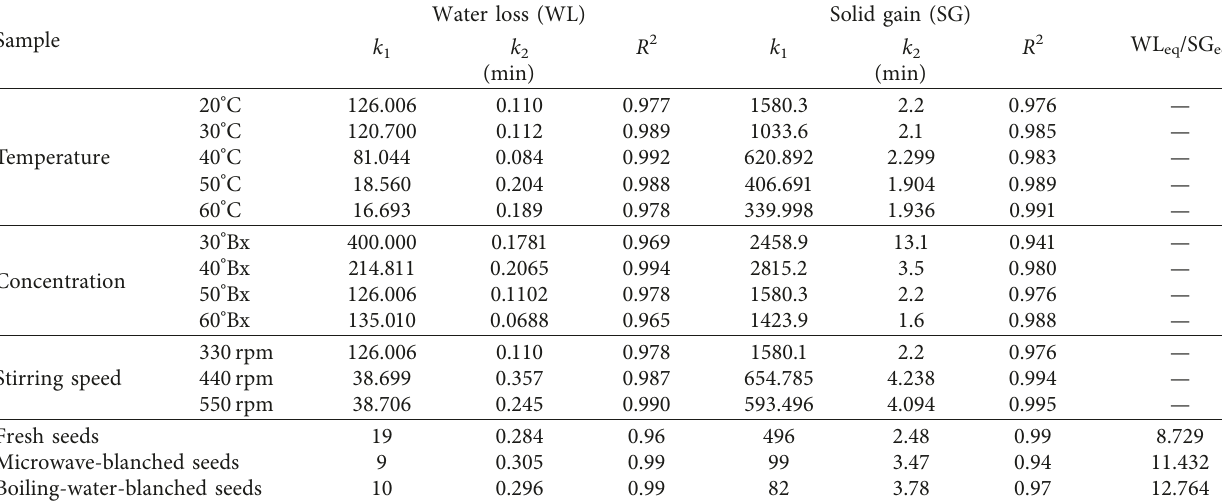
1: 4). (cid:31) Table 1: Peleg’s parameters.